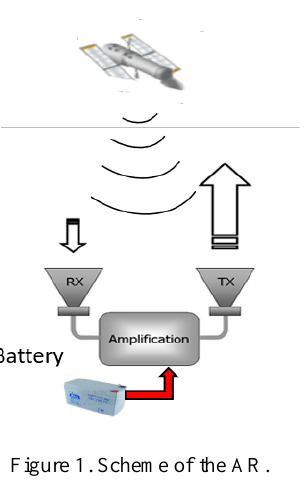
Figure 1. Scheme of the AR.